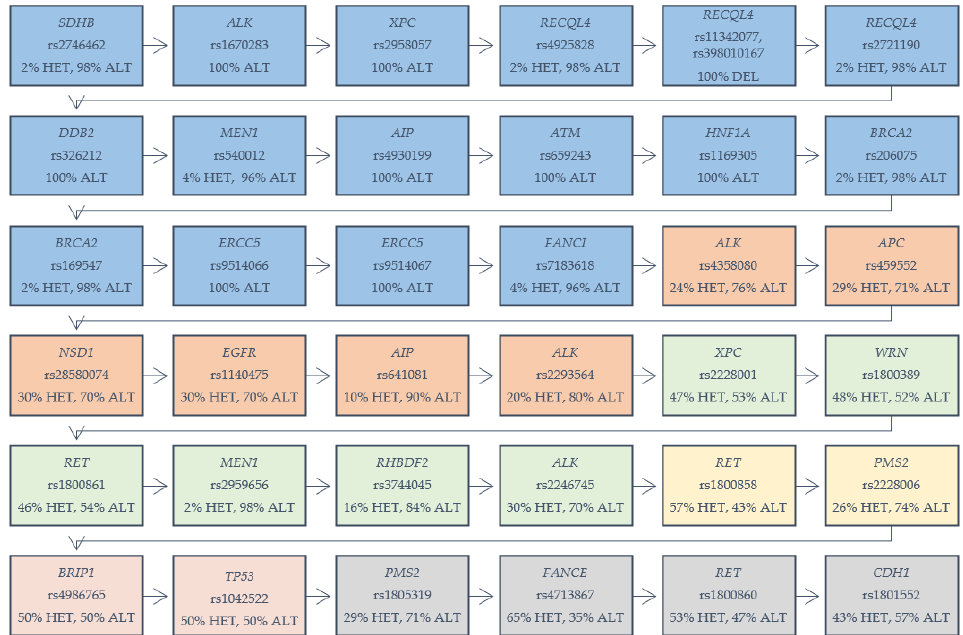
Figure 1. Variants in genes detected in gastric cancer samples (both early-onset gastric cancer (EOGC) and conventional gastric carcinoma (CGC)). HET: heterozygous variant; ALT: alternative homozygous variant. Five colored boxes are displayed: blue: 100% percent of cases with the mentioned variant; orange: one reference homozygote in the analyzed cases; green: two reference homozygotes; yellow: three reference homozygotes; red: four reference homozygotes; gray: five reference